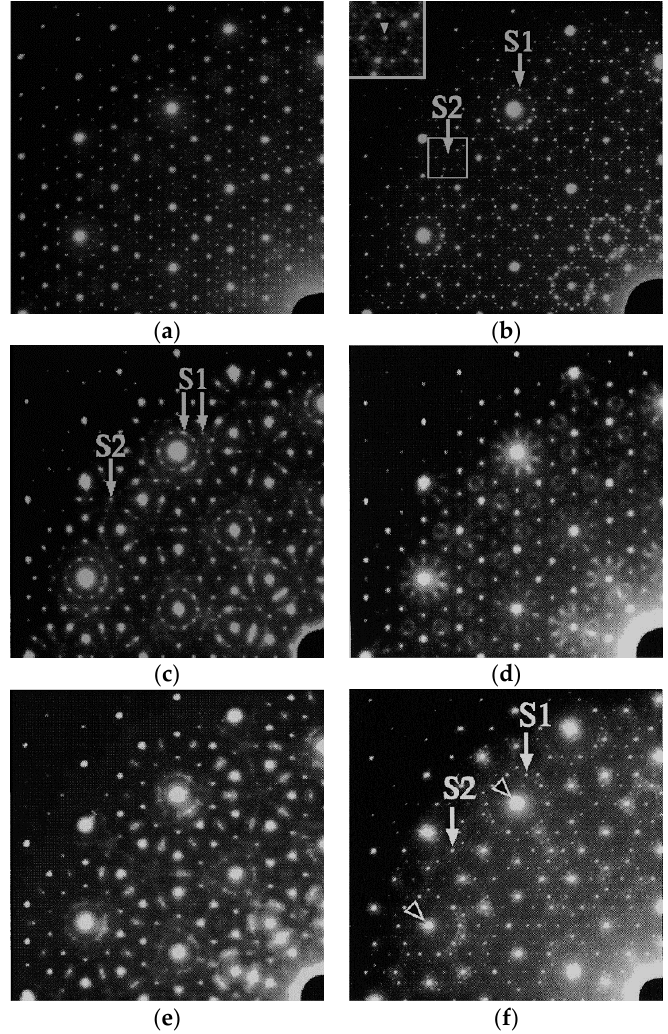
Figure 3. A quarter of SAED pattern of different decagonal Al–Co–Ni structures: ( a ) Ni-rich basic structure; ( b ) S1-type; ( c ) Type-I; ( d ) Type-II; ( e ) transition state between types I and II; and ( f ) type I superstructure of five-fold QC (reproduced from reference [57] with permission).